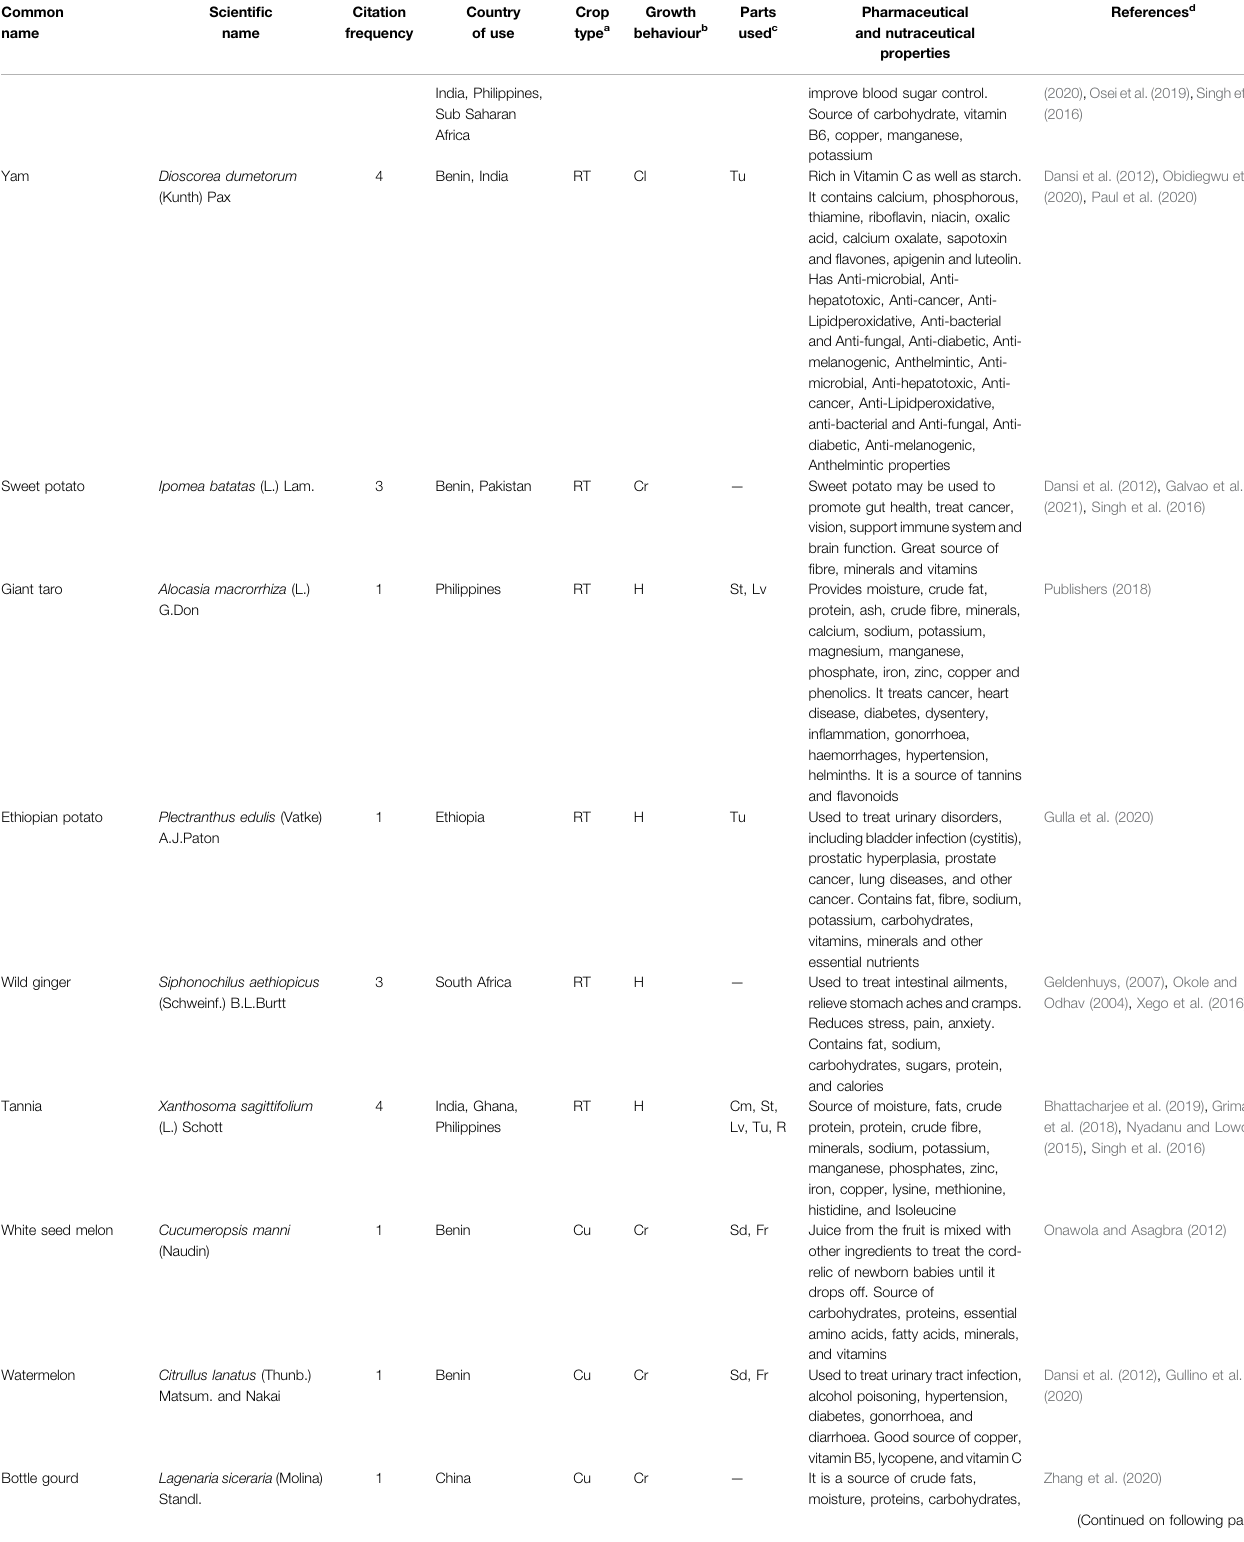
TABLE 1 | ( Continued ) Results of neglected functional medicinal crop species from the systematic review. 1 Crop type -Legume (L), Herb (H), Cereal (C), Cucurbit (Cu), Root and tuber (RT), Tree (T), Shrub (S), Leafy vegetable (LV), Pseudocereal (P) 2 Growth behaviour - Herb (H), Creeper (Cr), Climber (Cl), Tree (T), Shrub (S), 3